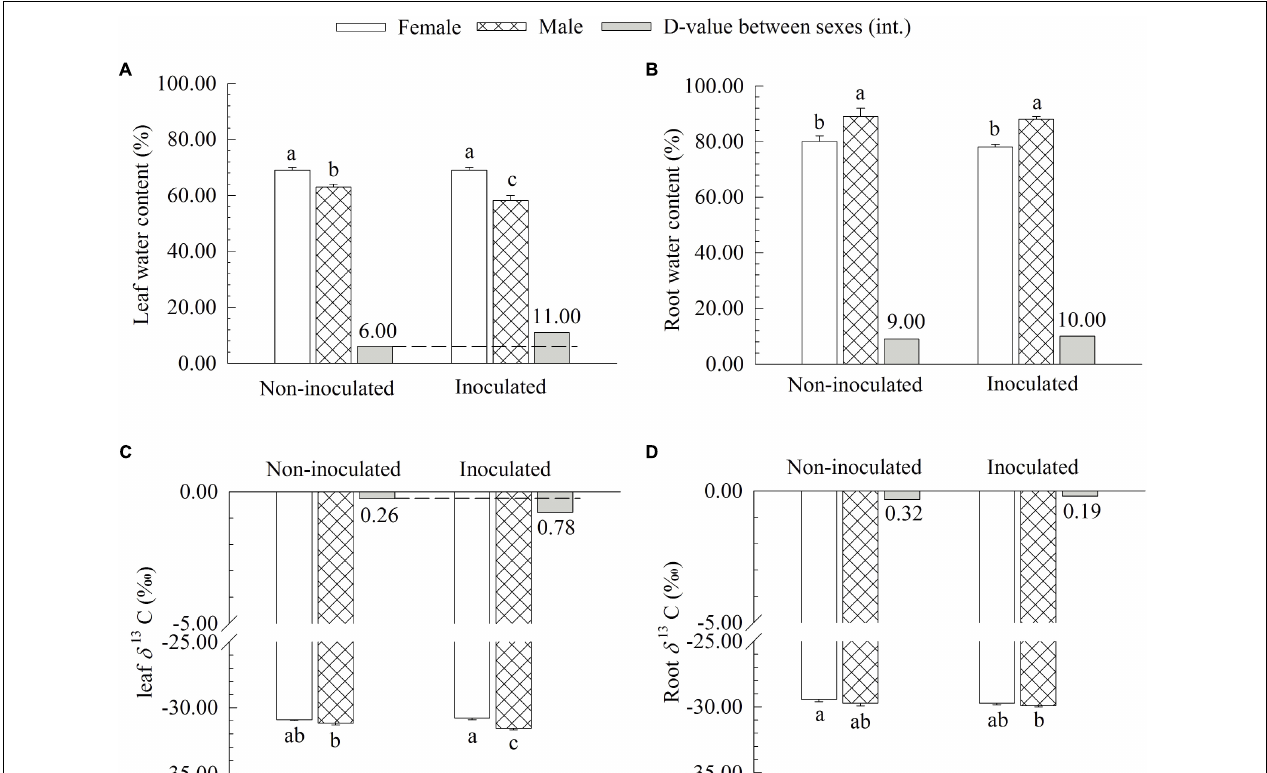
FIGURE 3 | The leaf water content (A) , root water content (B) , leaf carbon isotope composition δ 13 C (C) , and root δ 13 C (D) of female and male Populus cathayana saplings as affected by arbuscular mycorrhizal (AM) fungi. Each value is the mean ± SE ( n = 5). Bars with different letters are significantly different at the P < 0.05 level according to Duncan’s